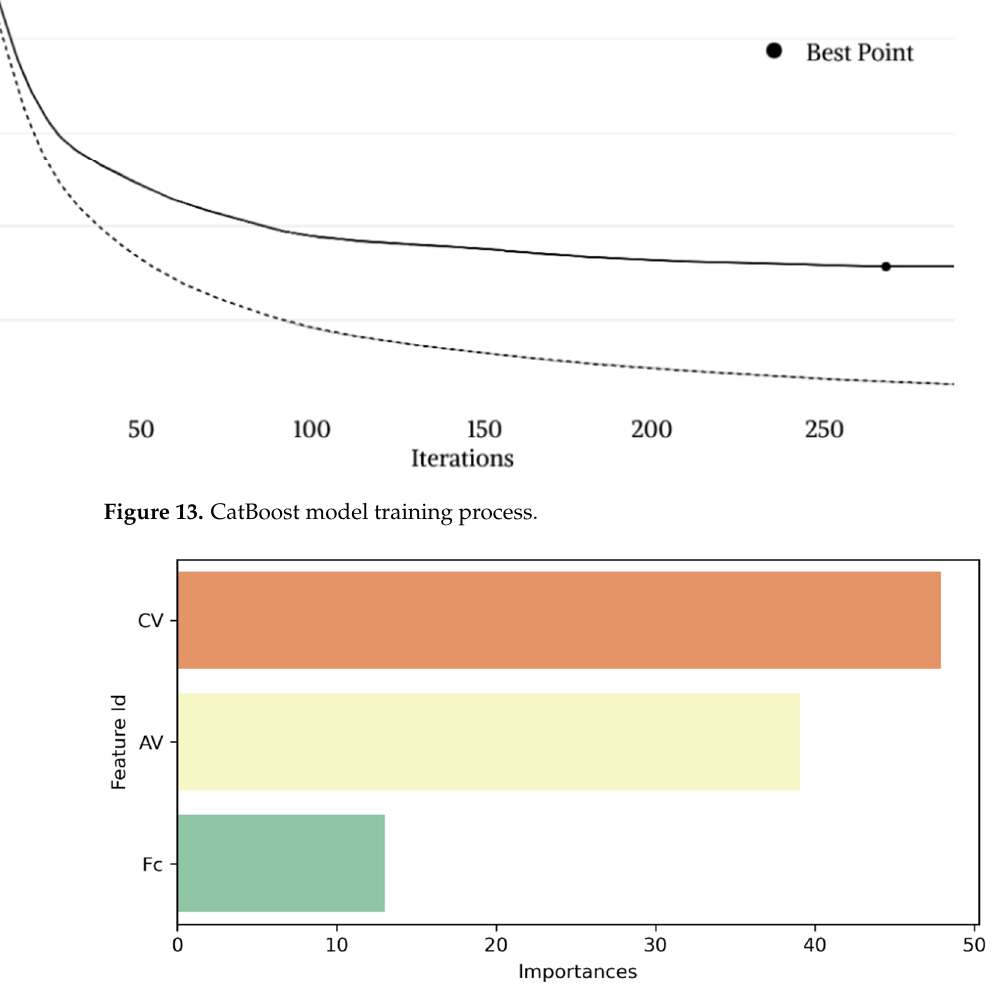
Figure 14. Feature importance.